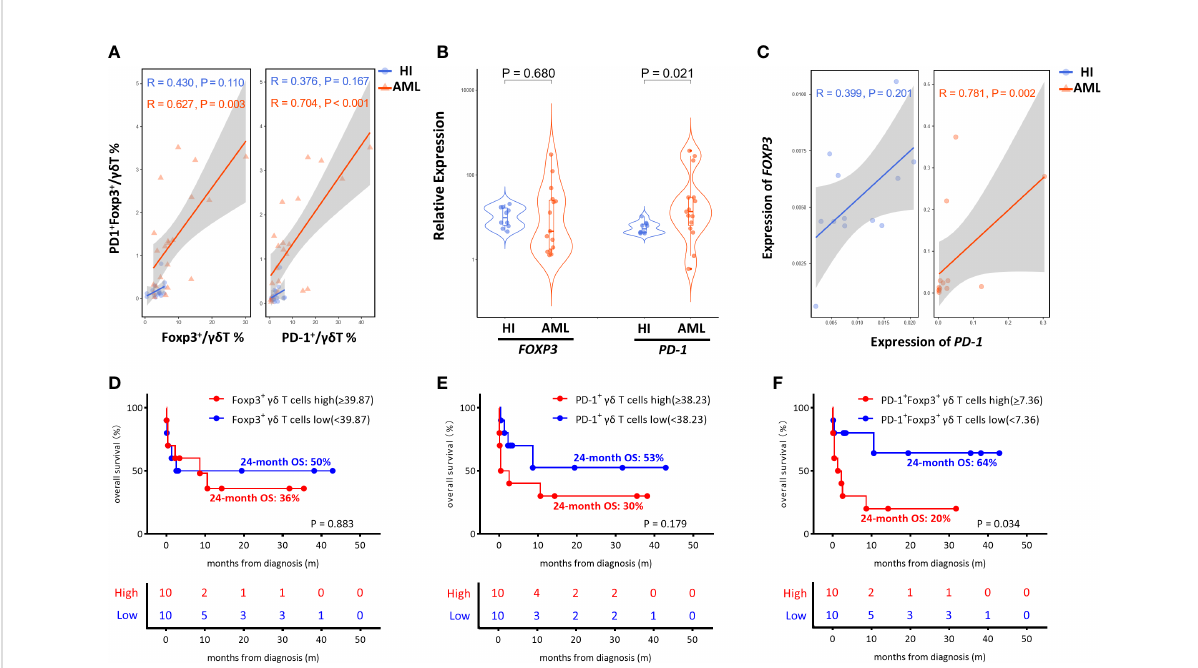
FIGURE 4 Correlation and OS analysis of PD-1 and Foxp3 in gd T cells from de novo AML patients. (A) Correlation of the frequency of the Foxp3 + , PD-1 + , and PD-1 + Foxp3 + gd T subsets between de novo AML patients and HIs. (B) The expression levels of the FOXP3 and PD-1 genes in gd T cells from de novo AML patients compared to HIs. (C) Correlation analysis of the FOXP3 and PD-1 genes. (D – F) Correlation of the OS of de novo AML patients strati fi ed by high and low Foxp3 + gd T subsets, high and low PD-1 + gd T subsets and high and low PD-1 + Foxp3 + gd T subsets. (D) Foxp3 + high vs. Foxp3 + low , 24-month OS: 36% vs. 50% P = 0.883. (E) PD-1 +high vs. PD-1 +low , 24-month OS: 30% vs. 53% P = 0.179. (F) PD-1 + Foxp3 +high vs. PD-1 + Foxp3 +low , 24-month OS: 20% vs. 64% P =